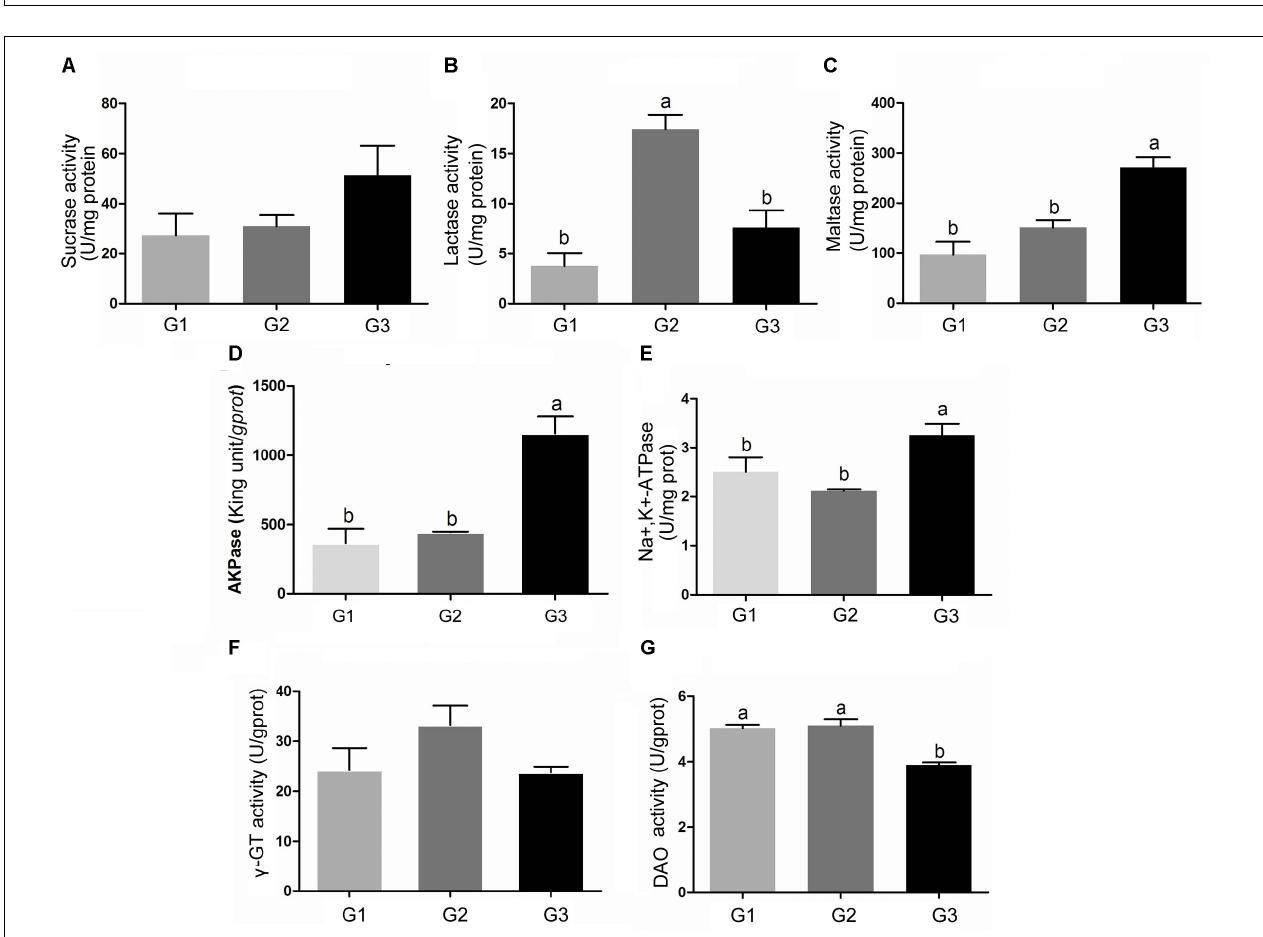
digestion and absorption of piglets. Previous study found that diet supplemented with Bacillus amyloliquefaciens partly instead of antibiotics dramatically improved the growth performance of